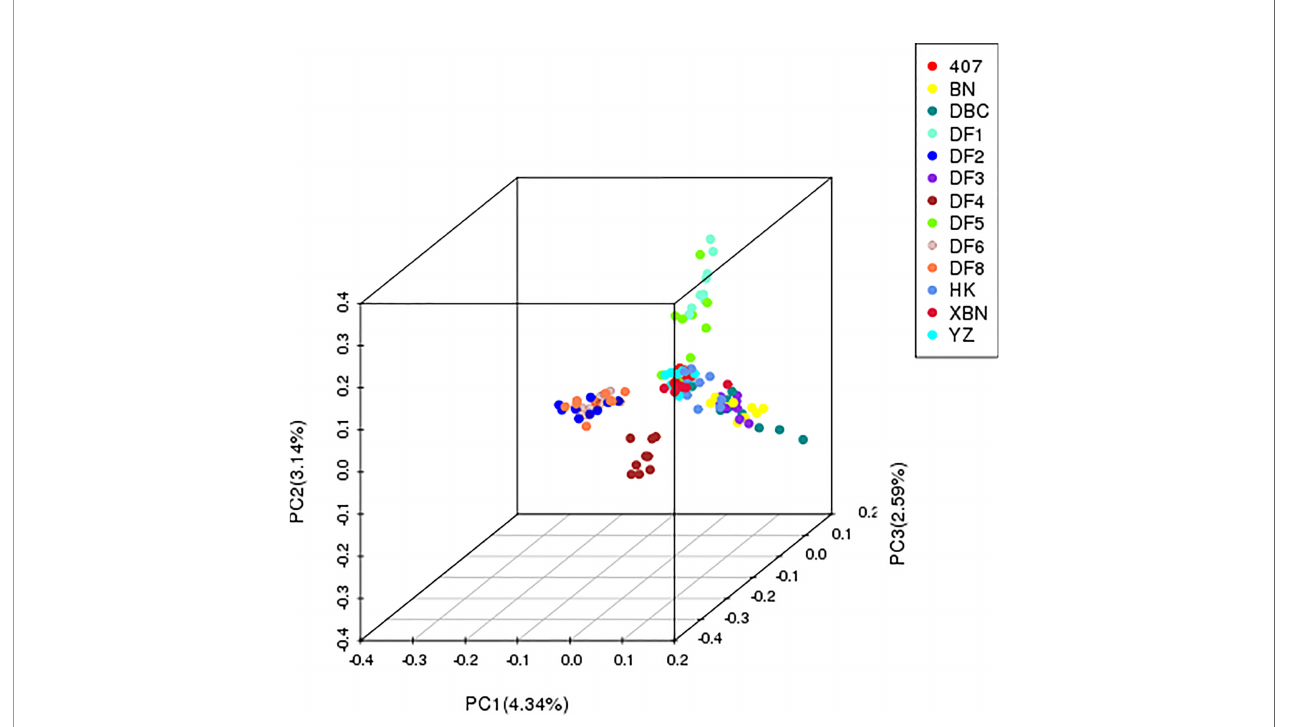
FIGURE 3 | PCA plot of the 13 cultivars based on the analysis of 340,398